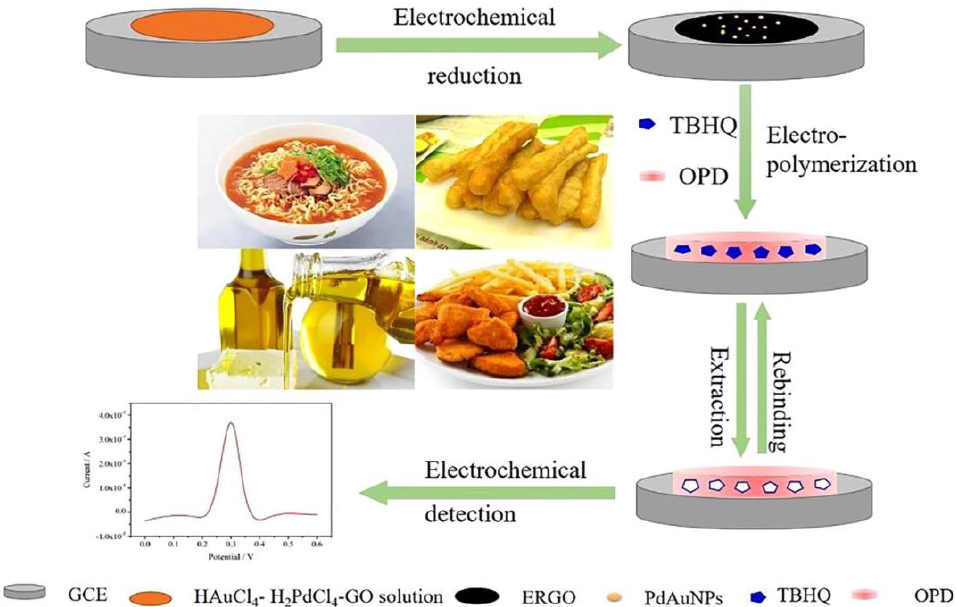
Figure 8. A schematic fabrication process of the MIP − based sensor for TBHQ detection. Adapted with permission from Ref. [109] . Copyright 2029, Elsevier.